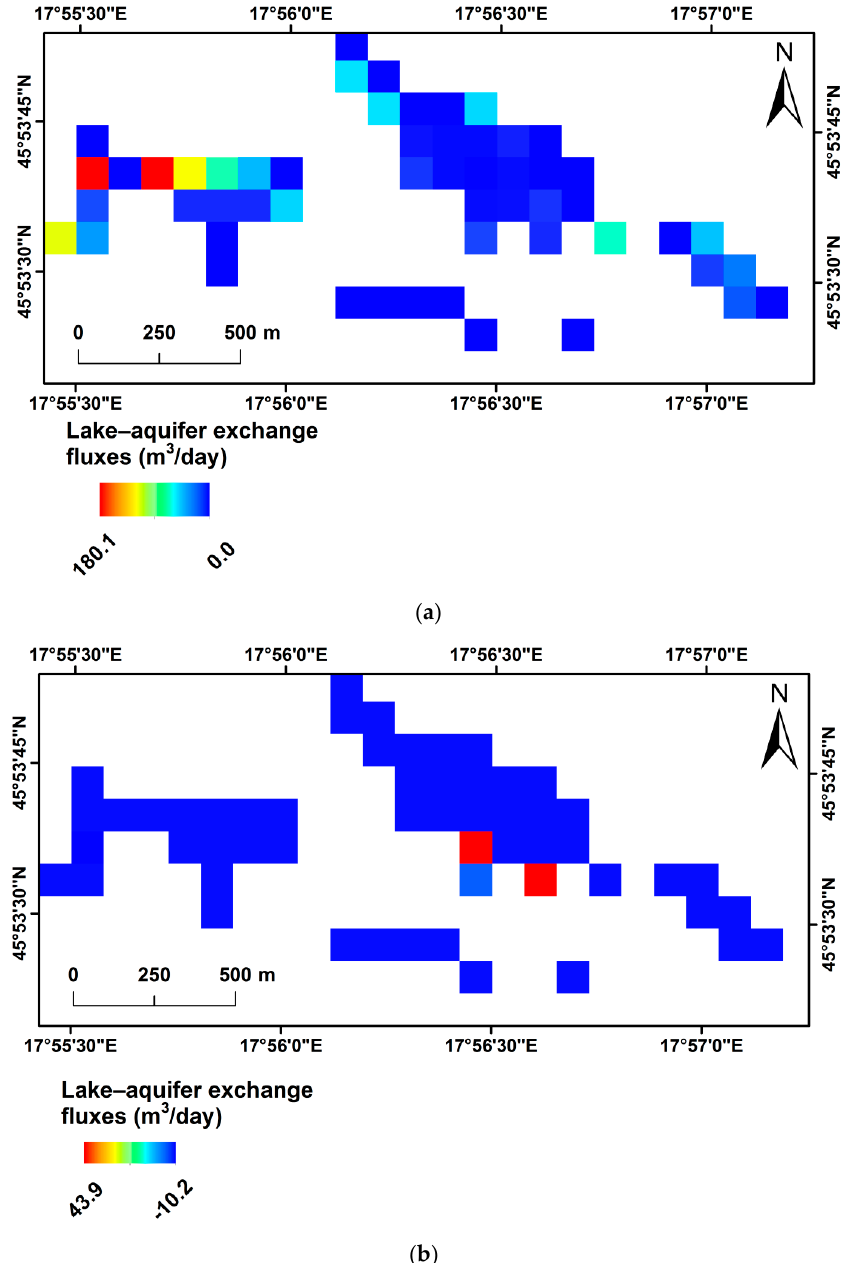
Figure 13. Lake–aquifer exchange fluxes of the Okor reservoir: ( a ) at the end of filling period of 10 days (+2 m reservoir stage), ( b ) for 40 days of the discharge period (+1 m) (positive represents upward reservoir seepage gain and negative represents downward reservoir seepage loss).